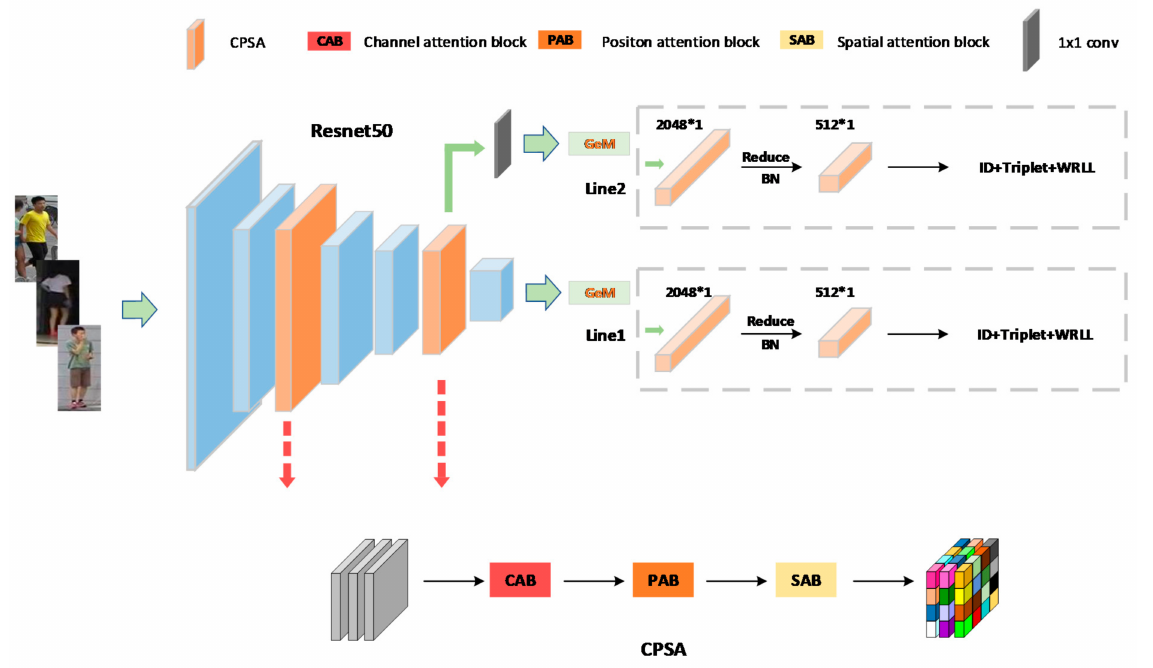
Figure 2. The overall design of DBA-Net. The orange block (left) represents the attention